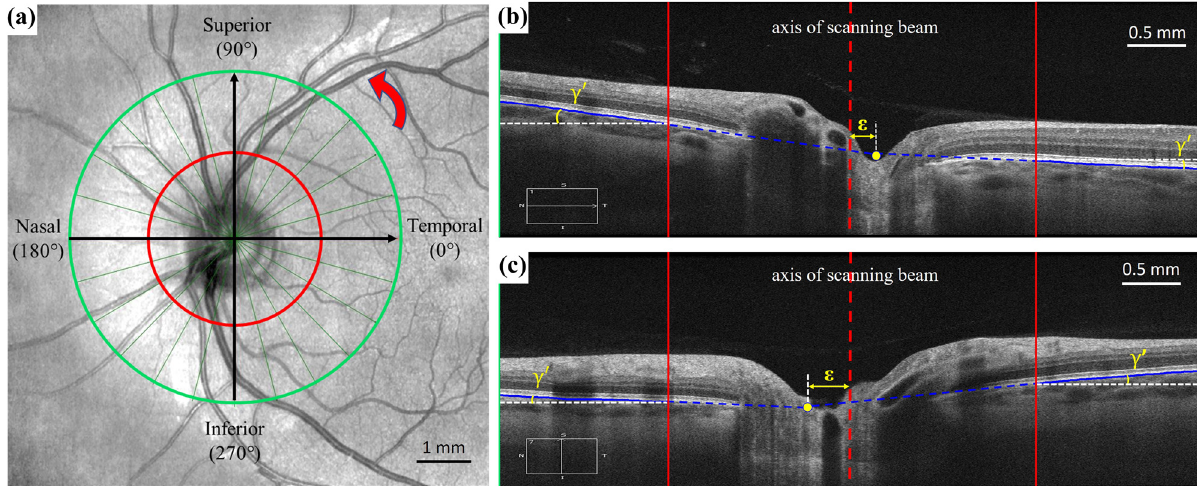
Figure 3: ( a ) Enface projection of the radial OCT centered over the optic disc. Twelve radial scans ( green line ) were acquired for each optic disc. The insert indicates the position of the corresponding scan shown in panel b ( nasal - temporal direction ) and panel c ( superior - inferior direction ) . The red circle marks the inner boundary of the peripheral region of the optic disc for segmentation, and the green circle marks the outer boundary of the OCT scan. The radial position of the scan was assigned counterclockwise ( marked with red circle arrow ) starting from 0° at the temporal direction. ( b ) The ppRPE/BM layer angle ( γ ′ ) and the eccentric distance ( ε ) in OCT scan at the nasal - temporal direction. ( c ) The ppRPE/BM layer angle ( γ ′ ) and the eccentric distance ( ε ) in OCT scan at the superior - inferior direction. In panels b and c, the red line marks the inner boundary of the ppRPE/BM layer, and the green vertical boarder marks the outer boundary of the ppRPE/BM layer. The solid blue line highlights the portion of the ppRPE/BM layer analyzed in this study, and the dashed blue line marks the extension of the ppRPE/BM layer. The dashed red line indicates the axis of the scanning beam. The solid yellow dot is the intersection point of the two extended lines ( dashed blue line ) of the ppRPE/BM